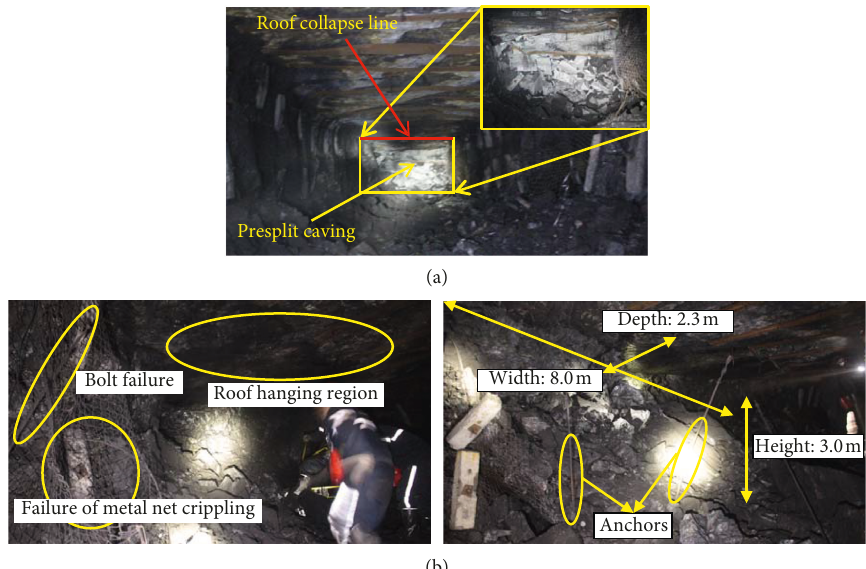
Figure 17: Shapes of the presplitted rock collapse and instability. (a) Roof collapse and (b) impact crushing of roadsides induced by blasting.